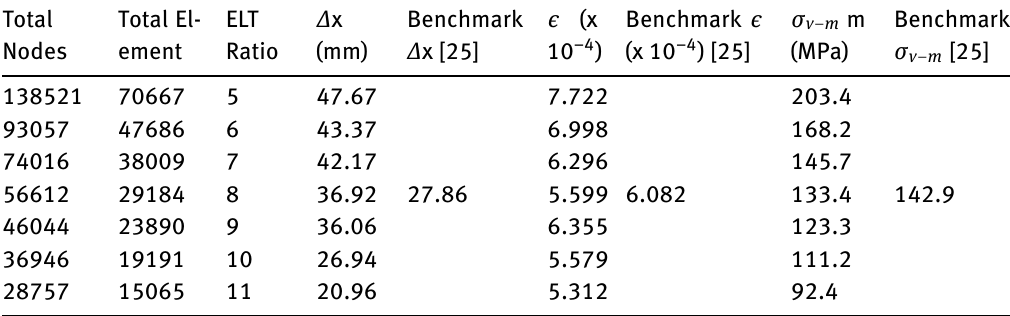
Table 1: Comparison with the results of the benchmark study.